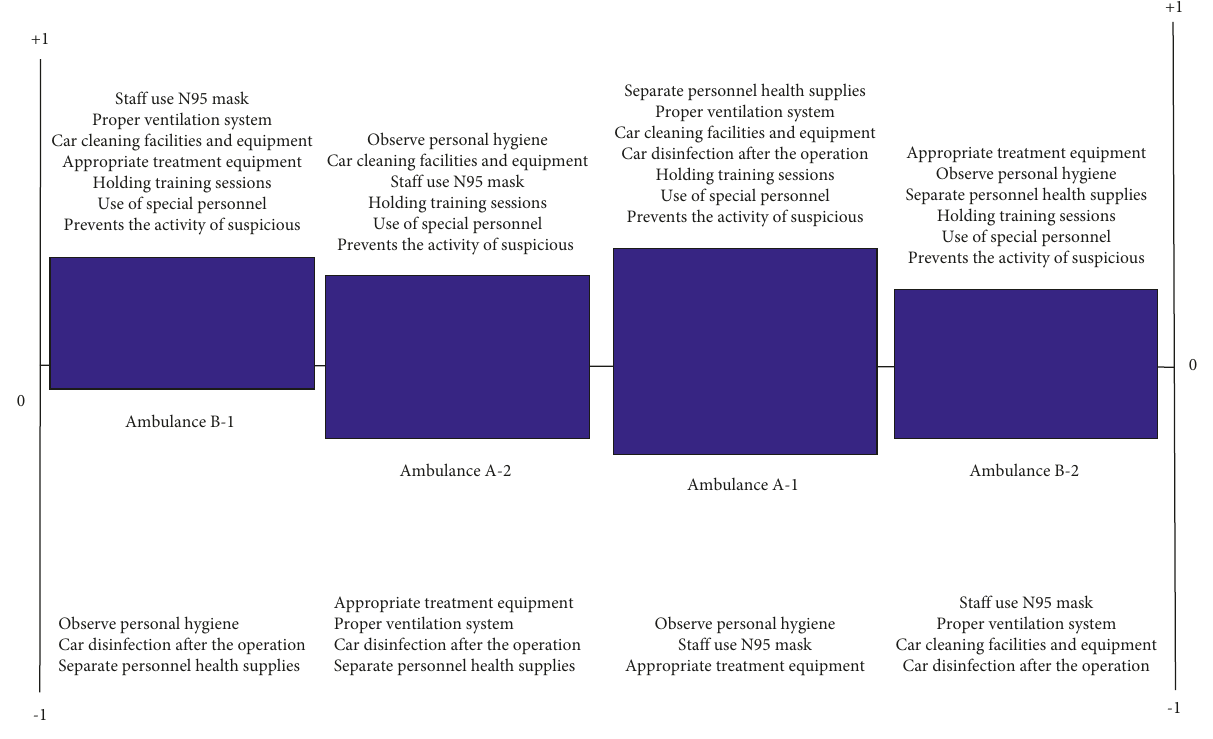
Figure 3: Rainbow diagram of